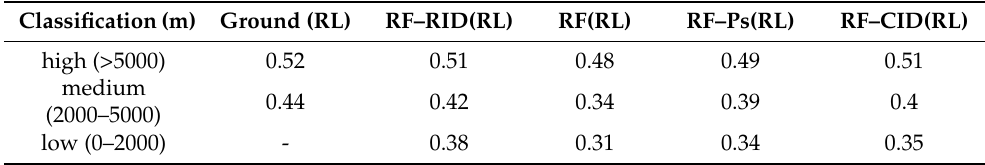
Figure 6. Spatial distribution of NO 2 concentrations in SWFJ on 10 January 2018. Simulation results for ( a ) RF–RID, ( b ) RF, ( c ) RF–CID, and ( d ) RF–Ps, where MAX represents the maximum NO 2 concentration value of the pixel, MIN represents the minimum NO 2 concentration value of the pixel, and the color column on the right represents the NO 2 concentration. Circles 1, 2, 3, and 4 in the upper and lower parts of the figure are magnifications of the corresponding circles in the study area. Table 2. Comparison of the correlation between different methods and